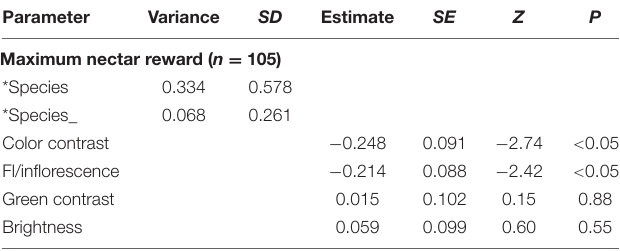
TABLE 2 | PGLMM for maximum nectar reward of single bagged flowers.